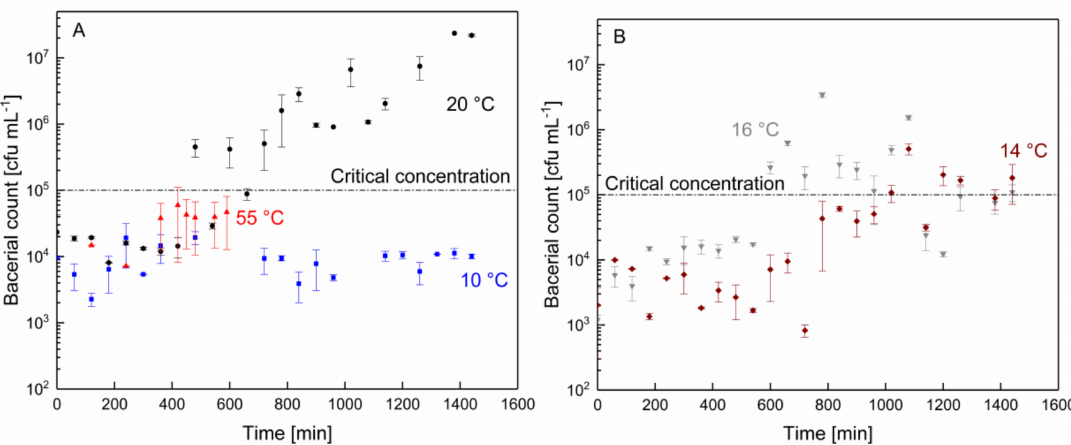
Figure 4. Bacterial count as a function of the processing time and temperature of ( A ) 10 C ( (cid:4) ), 20 C ( • ), and 55 ◦ C ( (cid:78) ), and ( B ) 14 ◦ C( (cid:95) ) and 16 ◦ C ( (cid:72) ). Dotted lines are guides for the